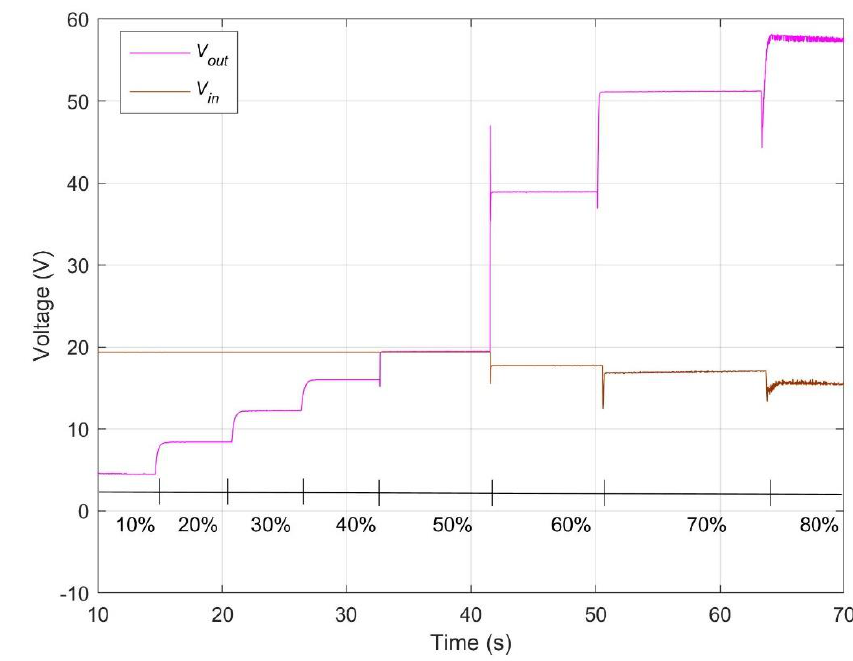
Figure 4. DC/DC converter input and output voltages for some D values.